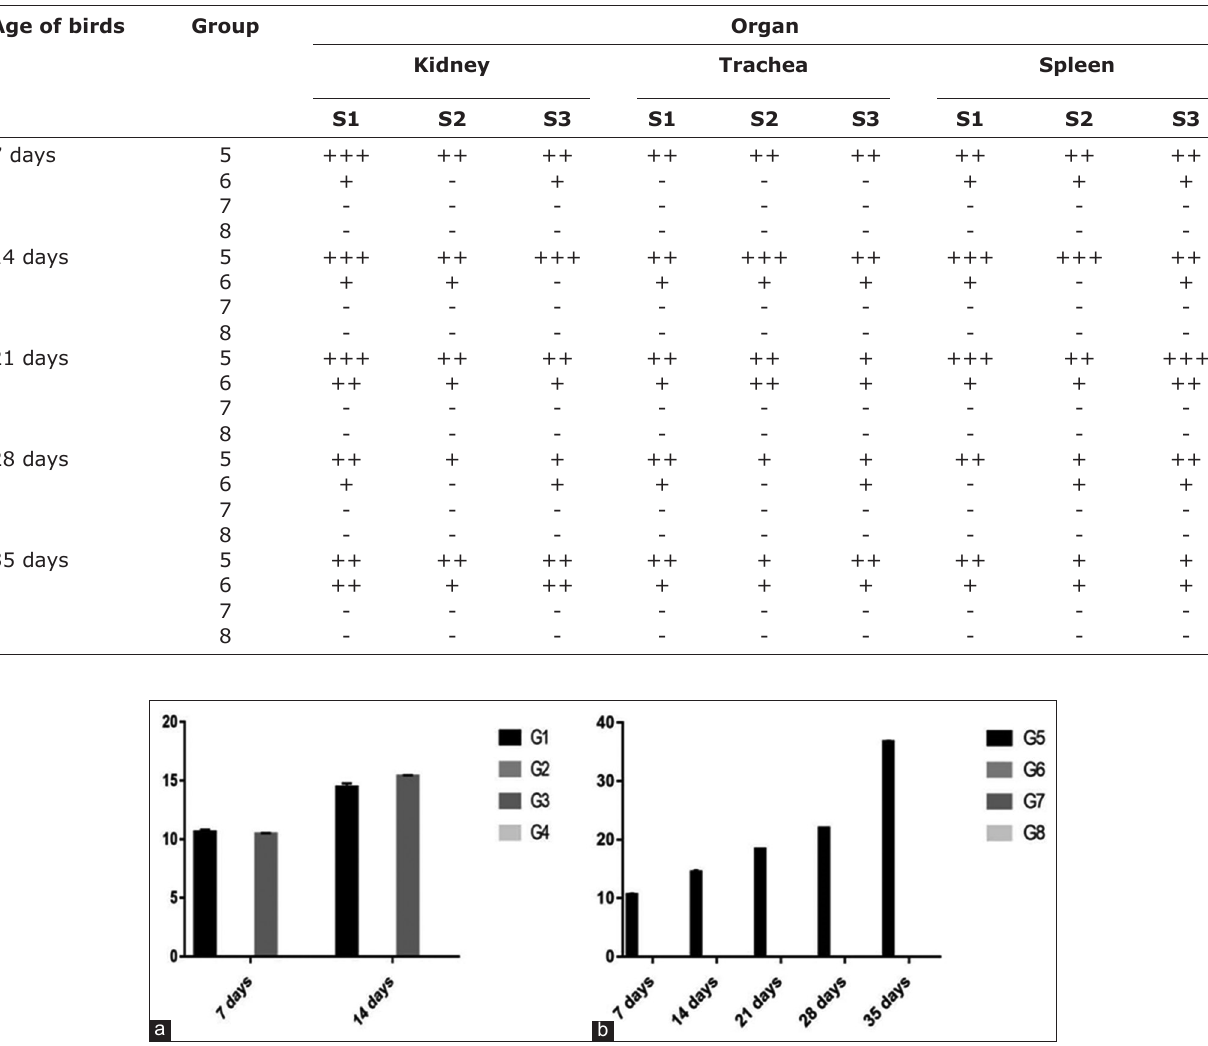
Table-5: The score pathological lesions for all groups in experiment 2. Age of birds